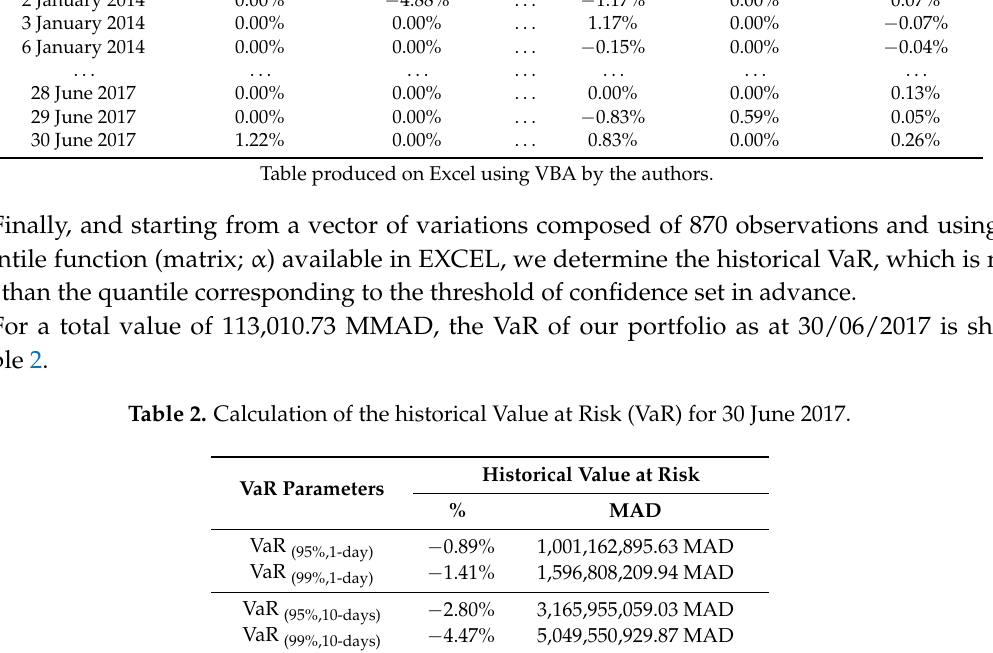
Table produced on Excel under VBA by the